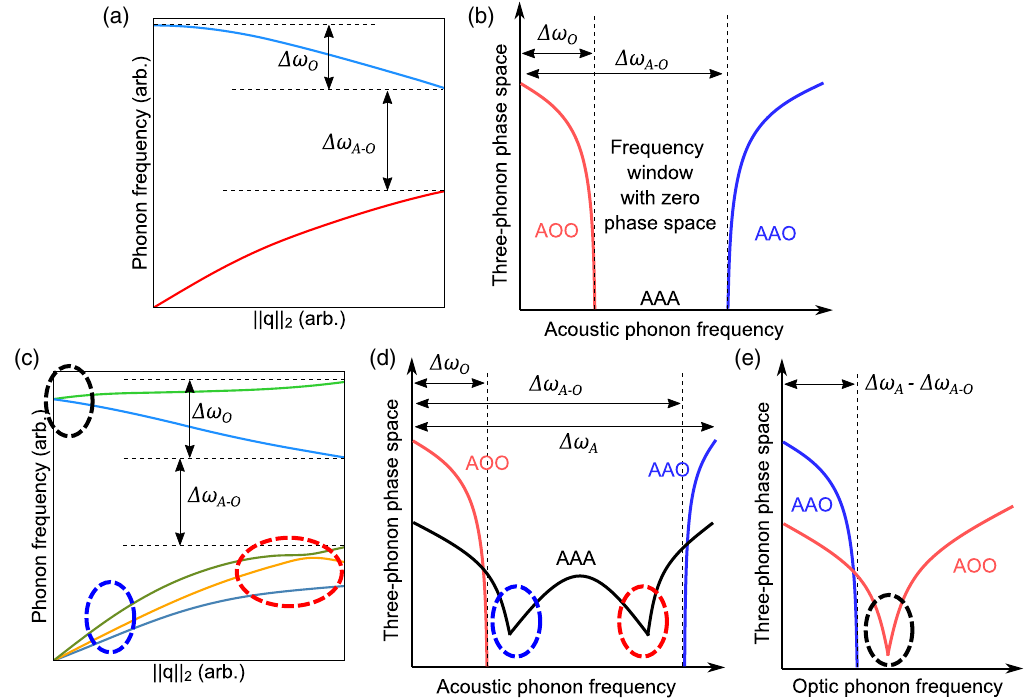
FIG. 2. Hypothetical phonon dispersions (a) and the corresponding three-phonon phase space (b), where degenerate acoustic phonons, a small optic phonon bandwidth ( Δ ω ), and a large A − O frequency gap ( Δ ω ) result in a frequency window for the acoustic O A − O phonons without any phase space for three-phonon scattering (due to AAO , AOO # 1 and AAA # 1 selection rules). Also shown are the features of the dispersions of a real material (c), where acoustic phonons having a large LA-TA velocity ratio (blue dashed oval) and/or being bunched together (red dashed oval) along with small Δ ω and a large A − O gap result in a frequency window with weak total O three-phonon scattering phase space due to AAO , AOO # 1 , AAA # 1 , and AAA # 2 selection rules (d). Furthermore, near degeneracy in the optic phonons [black dashed oval in (c) and (e)] along with a large A − O gap can result in weak three-phonon scattering phase space for the optic phonons due to AAO and AOO # 2 selection rules. The curves labeled AAA , AAO , and AOO in (b), (d), and (e) show schematically the regions in which the corresponding three-phonon processes